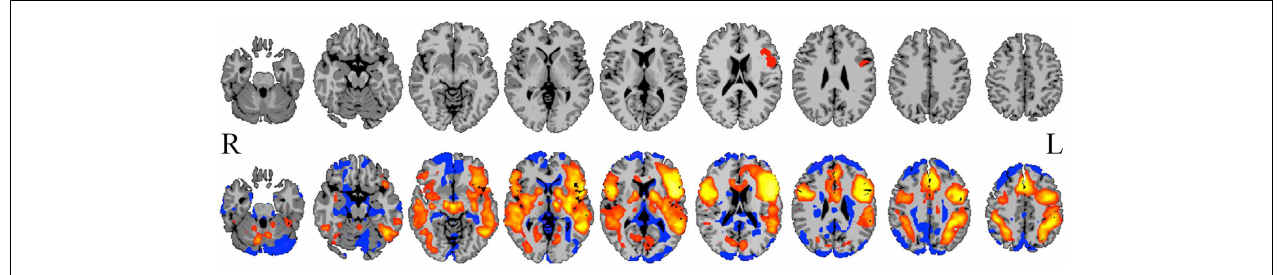
FIGURE 1 | Seed-to-whole-brain connectivity mapping . A reference BOLD signal time-course from a seed in Broca’s area (top row) is correlated with the BOLD time-course for all gray-matter voxels in the image, revealing areas to which the seed is functionally connected (bottom row; hot colors = strong positive correlation, cool colors = weak or negative correlation).